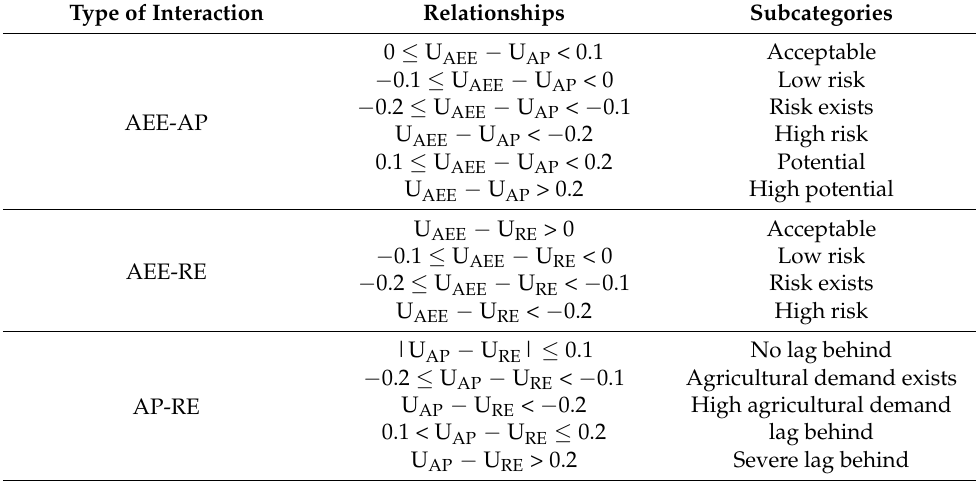
Table 3. Coupling relationship between the